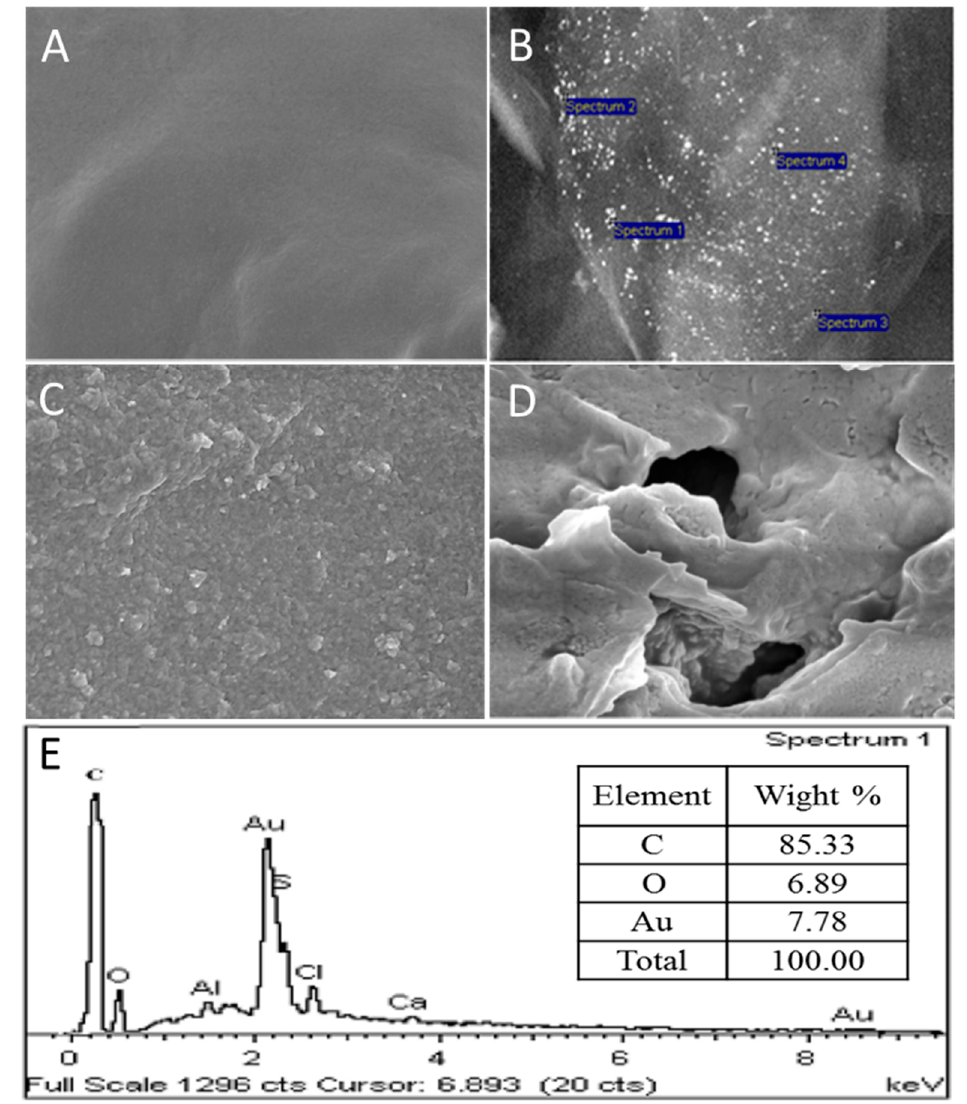
Figure 1. FESEM images of ( A ) Chitosan, ( B ) Gr-Au, ( C ) Gr-Au-Chit and ( D ) Gr-Au-Chit/Tyr, ( E ) EDX spectrum surface of Gr-Au-modified SPCE. EDX = Energy Dispersive X-Ray spectroscopy; SPCE = screen-printed carbon electrode.